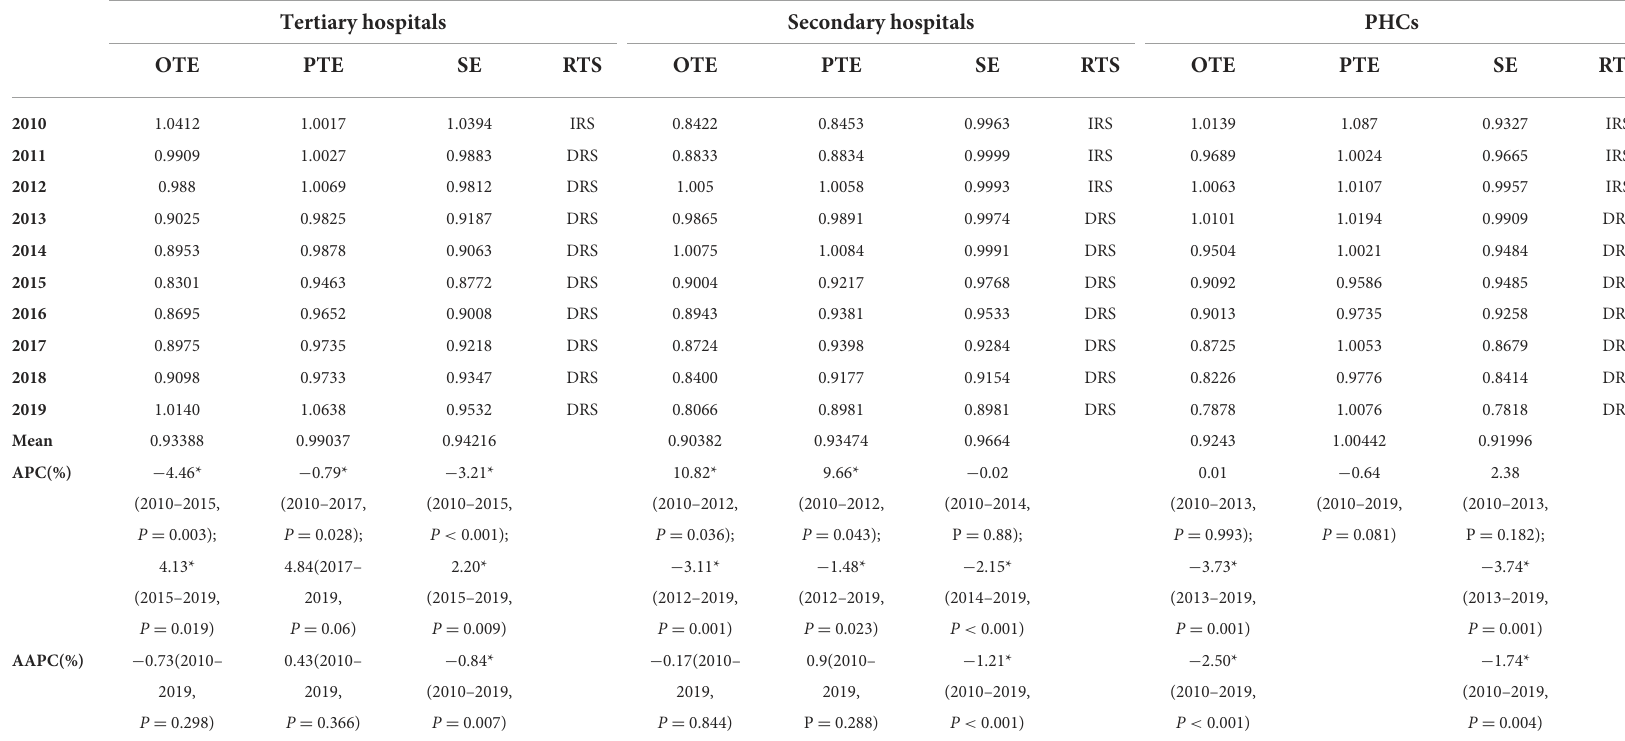
TABLE 4 The overall efficiency scores of medical institutions at various